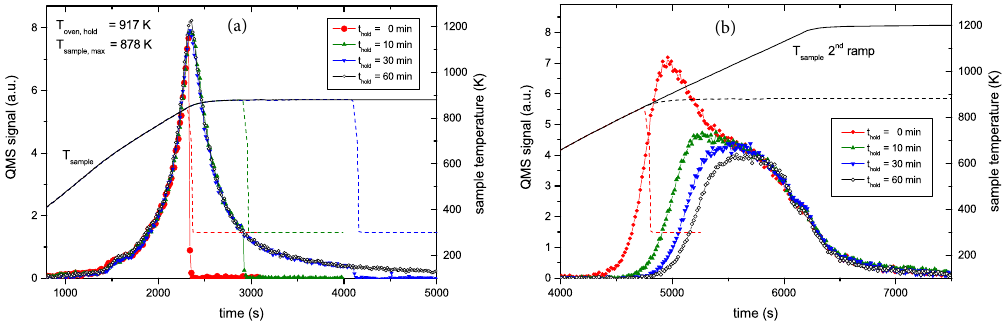
Figure 5. Results from R&H experiments for T hold = 878 K (nominal temperature ramp of 15 K/min). ( a ) shows a comparison of the desorption peaks measured during the first ramp and hold phase as a function of time (left-hand scale). The sample temperature is also shown (right-hand scale). The holding time is varied between 0 and 60 min. The desorption signal decreases strongly during the holding phase; it abruptly falls to zero when the oven is removed at the end of the holding